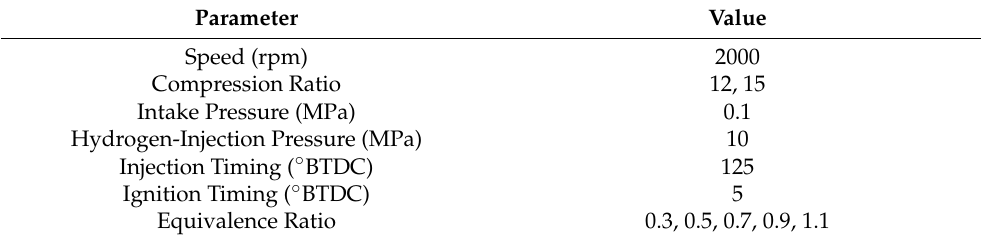
Figure 3. In-cylinder pressure and temperature curves for different equivalence ratios [48]. ( a ) CR = 12. ( b ) CR = 15.